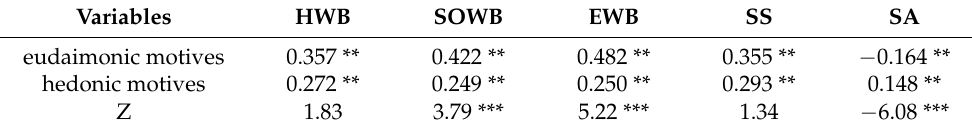
Table 4. Correlation among variables and the difference of the correlation